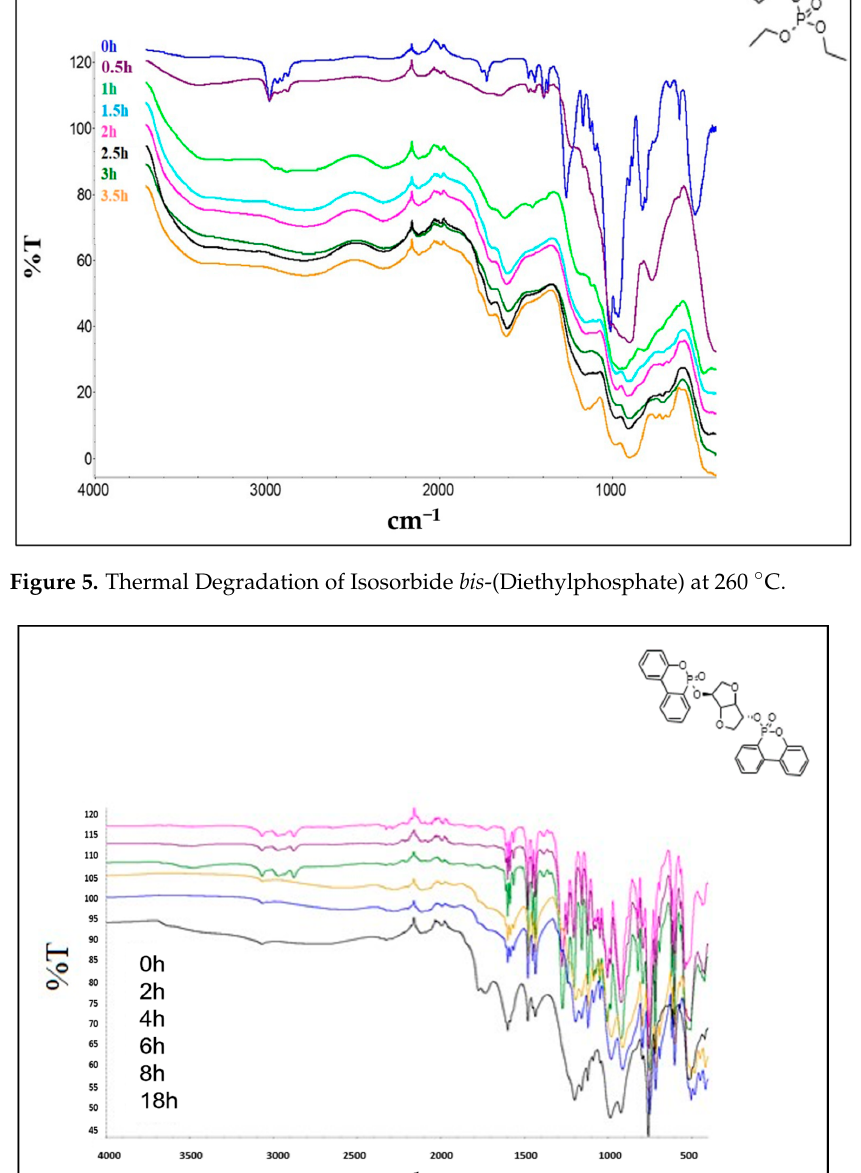
Figure 6. Thermal Degradation of bis -Dopyloxyisosorbide at 250 °C.